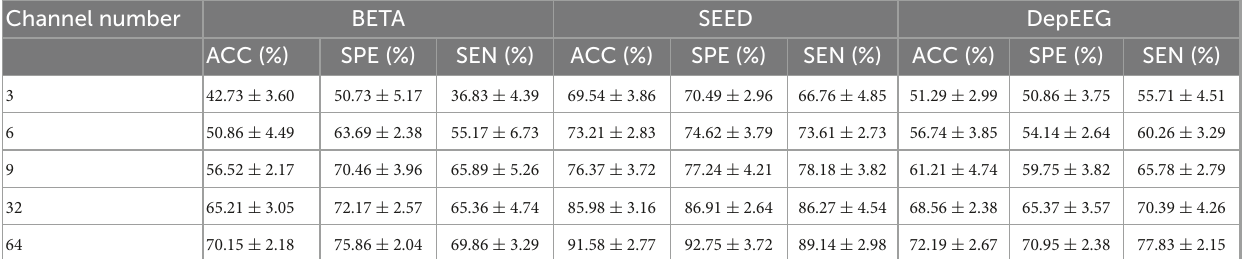
TABLE 3 Classification results (ACC, SPE, SEN, and their corresponding SDs) of our model is reported versus varying number of channels and 1.0 s of stimulation. Channel number